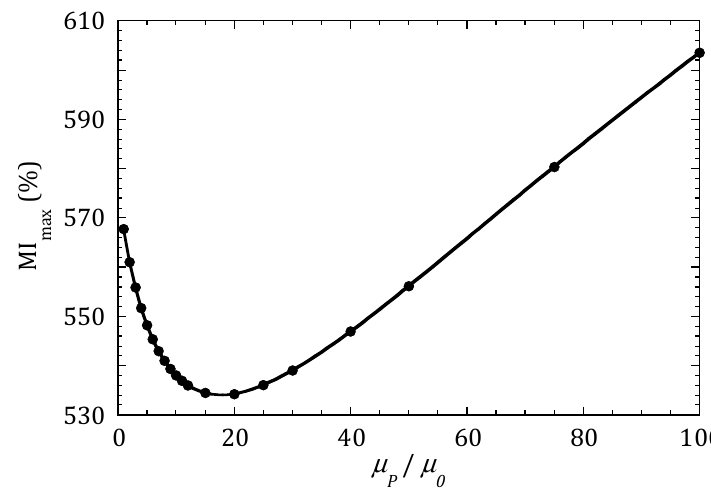
Figure 5. Maximum MI ratio of a sensor with µ max = 5000 µ 0 when a drop of MNPs is placed on it, as a function of the concentration of nanoparticles (expressed as increasing permeability µ P values). 211